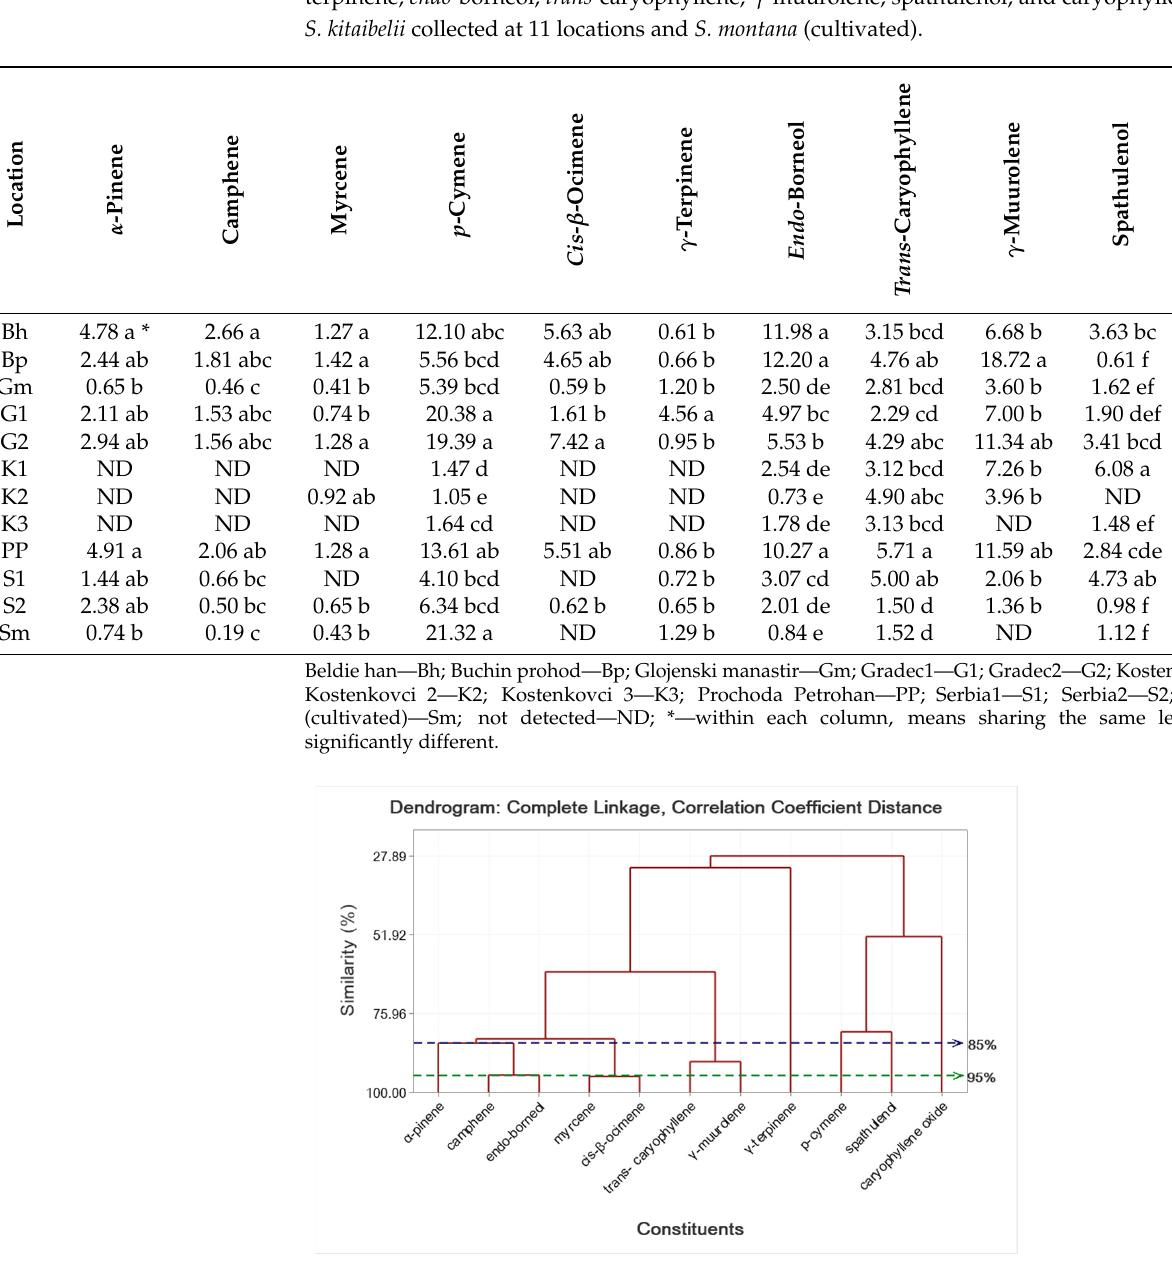
Figure 2. Complete linkage dendrogram showing the similarity of 11 constituents collected from 12 locations of S. kitaibelii and S. montana listed in Table 8.